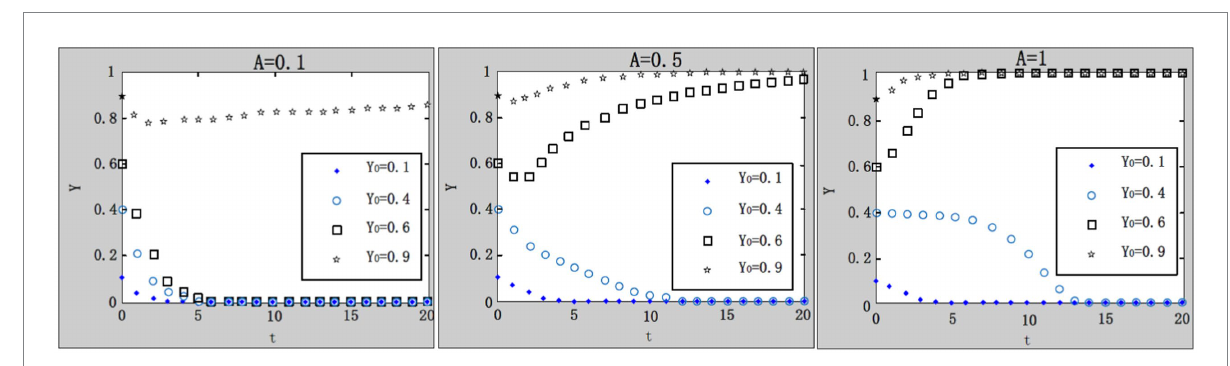
FIGURE 5 Influence of local government subsidies on system evolution.